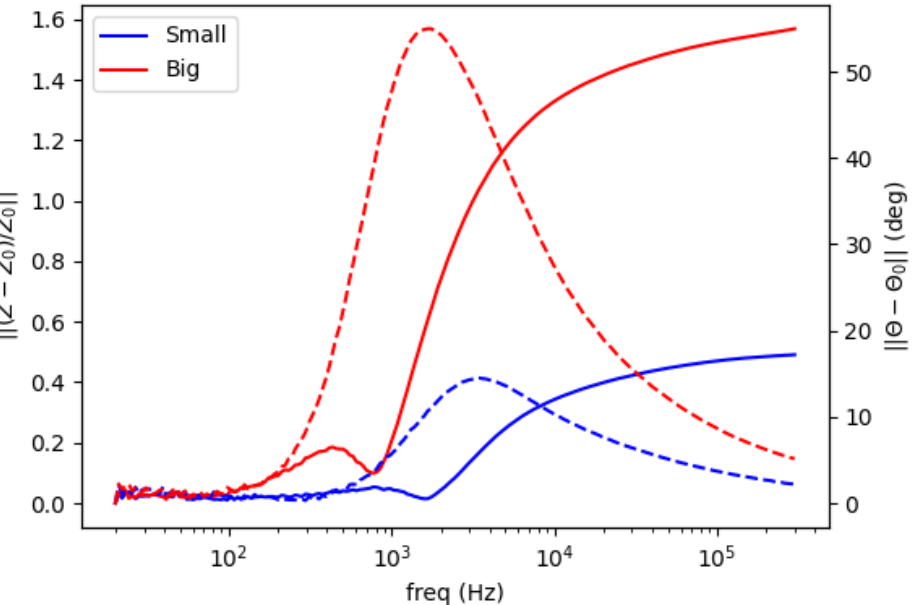
Figure 5. Spectral plot for size variations. Solid line for amplitude ratio (left vertical axis); dashed line for phase difference (right vertical axis).